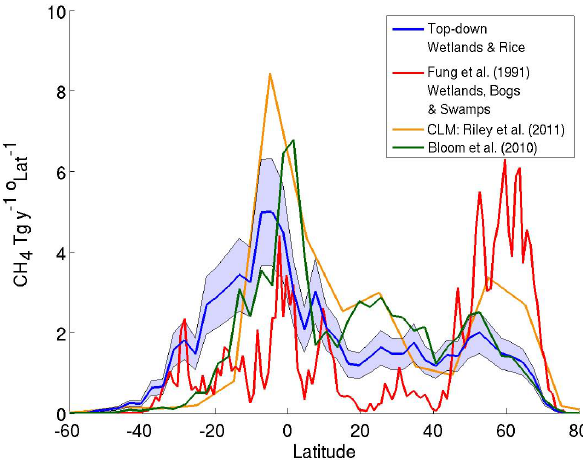
Fig. 4. Zonal profile of CH 4 emissions from wetlands and rice pad- dies: top-down wetlands and rice, this study (blue); wetlands, bogs and swamps, (Fung et al., 1991, red); wetland and rice paddy emis- sions (Riley et al., 2011, orange); wetland and rice paddy CH 4 emis- sions (Bloom et al., 2010, green). Riley et al. (2011) attribute their elevated tropical fluxes to anomalously high predicted net primary productivity in the Community Land Model (CLM version